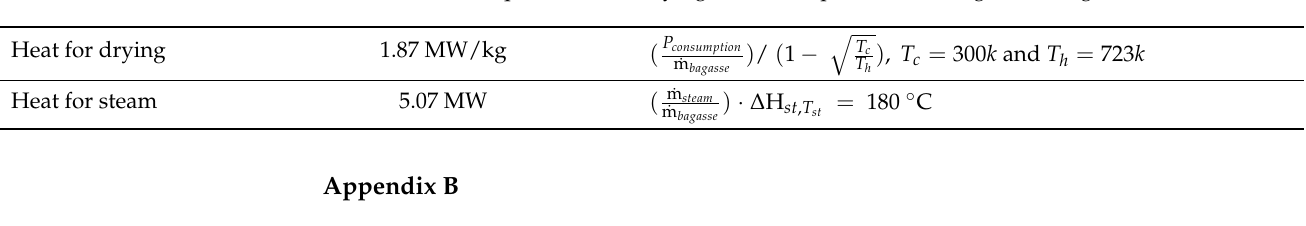
Table A3. Heat requirement for drying and steam production (1 kg/s wet bagasse).